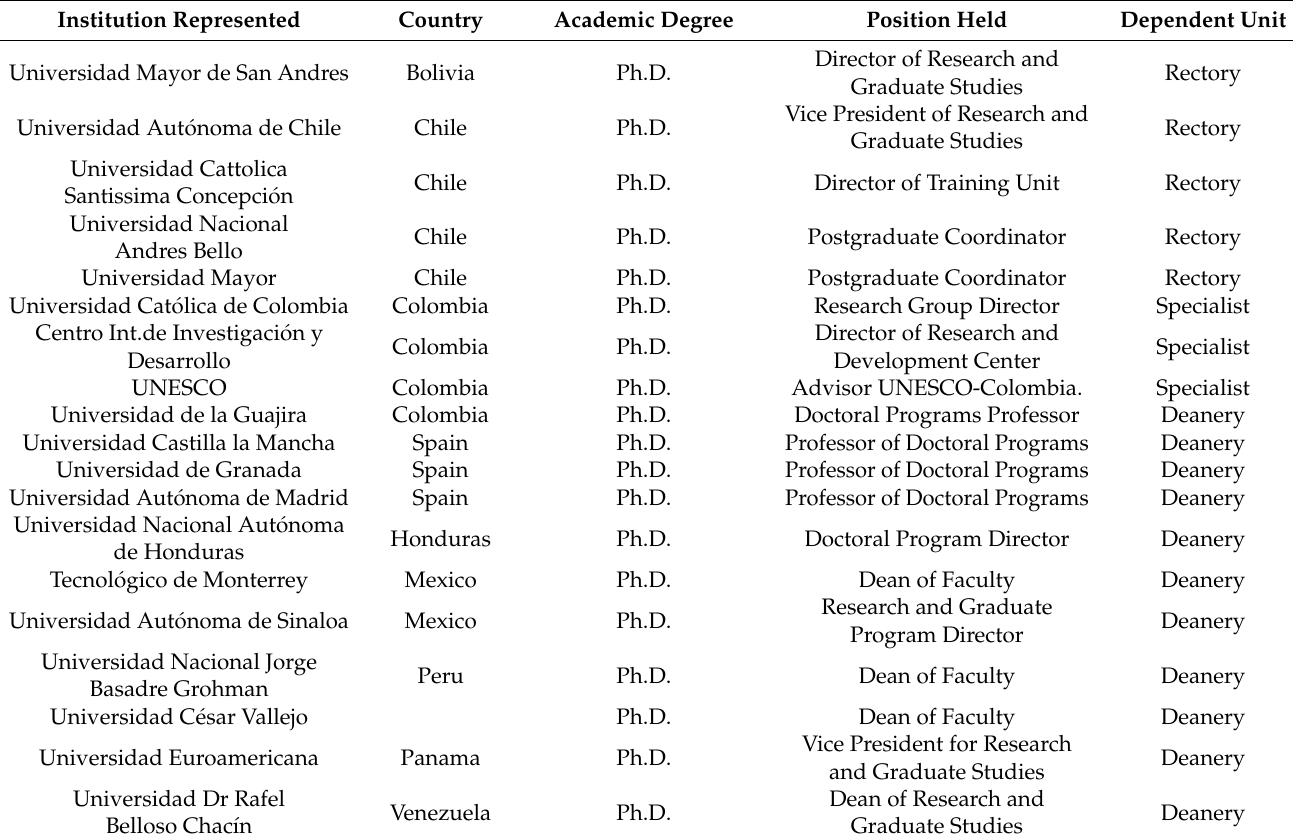
Table 1. Distribution of unit of